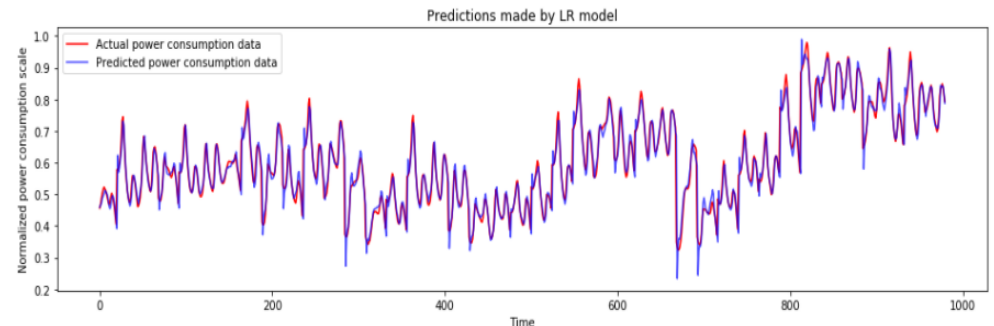
Figure 6. Forecast result of ARIMA model with respect to test dataset over time (day).